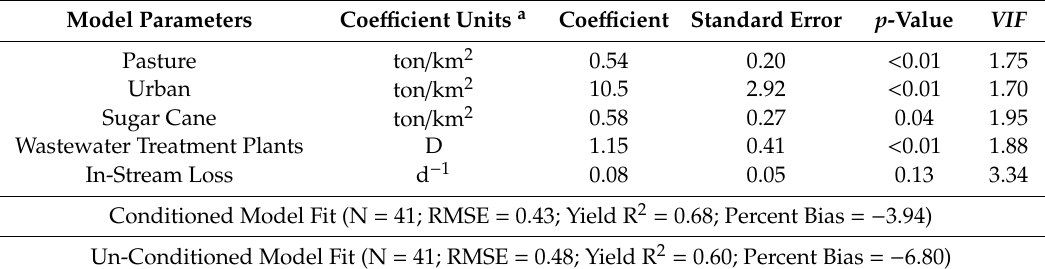
Table 2. SPARROW model coe ffi cients and model statistics for both conditioned and un-conditioned model